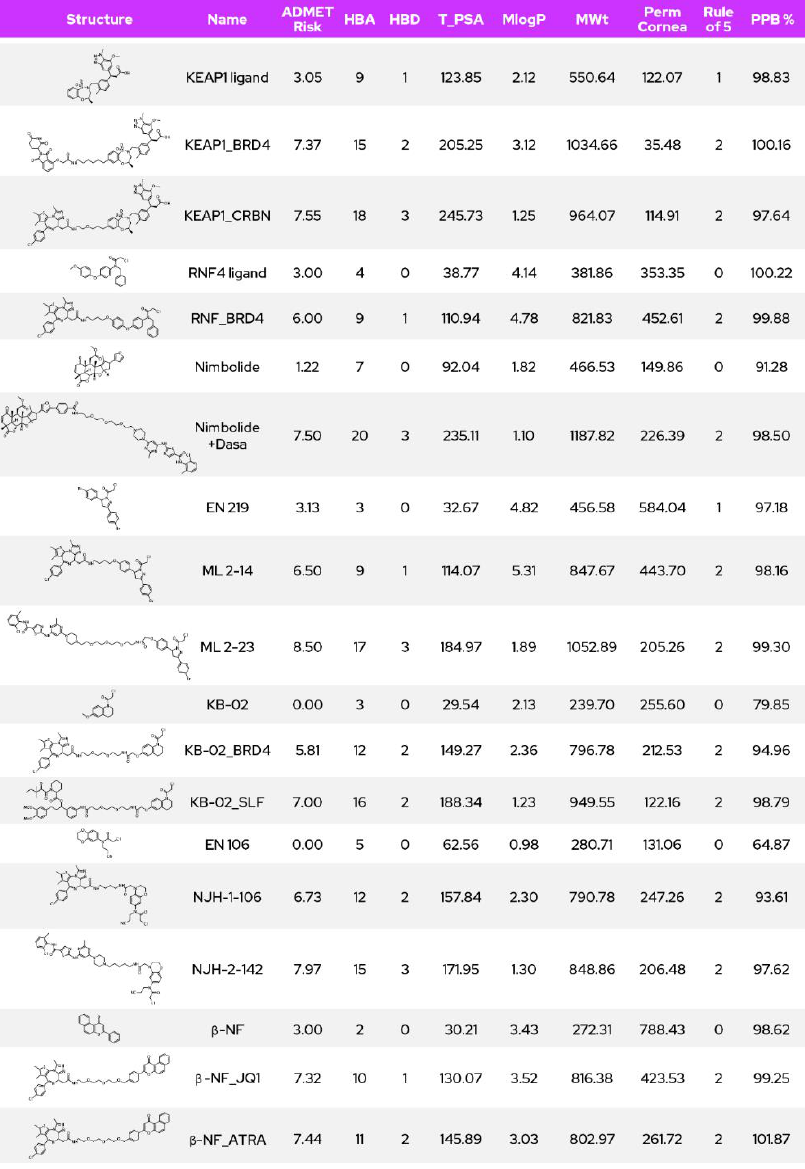
Figure 7. PROTACs utilizing novel recruiters.